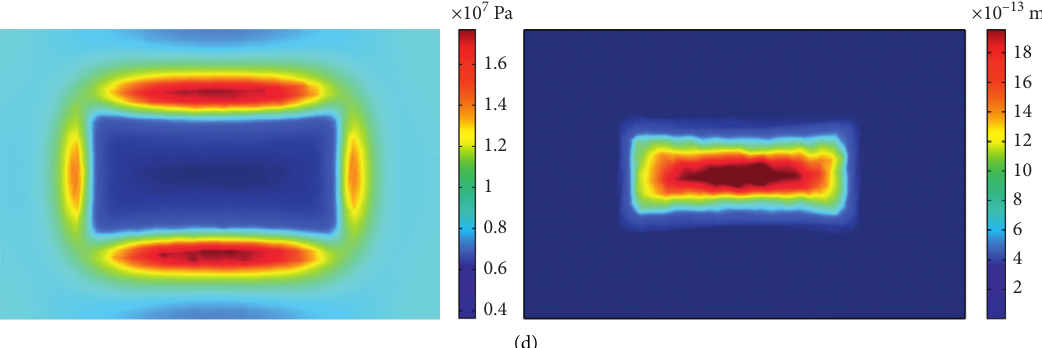
Figure 6: Stress field and permeability evolution law of the protected layer in #3 coal seam: working face of #8 coal seam advancing (a) 40m, (b) 80 m, (c) 120m, and (d) 480m.